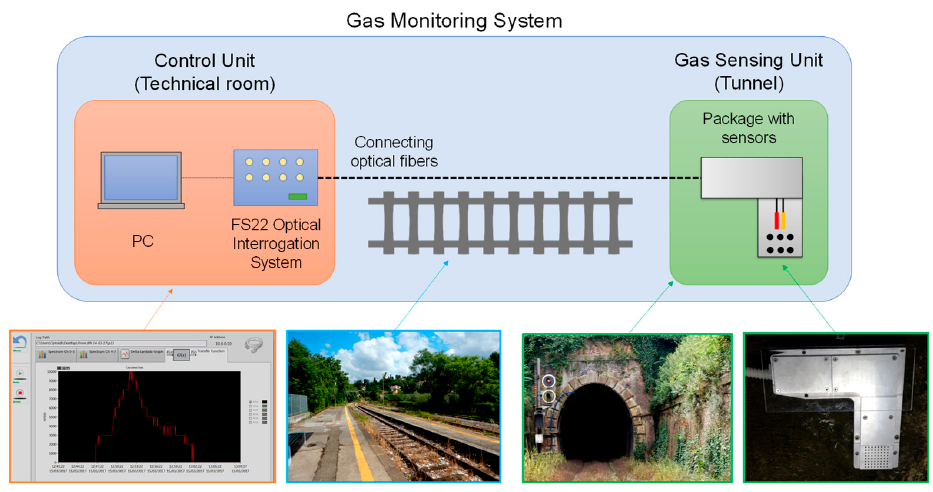
21 of 32 Figure 18. LPG-based gas sensor: ( a ) spectra acquired during fabrication steps (inscription, reflection configuration and with aPS coating); ( b ) response to different butane mixtures below the LEL, in terms of resonance wavelength shift. (Adapted from [147]).